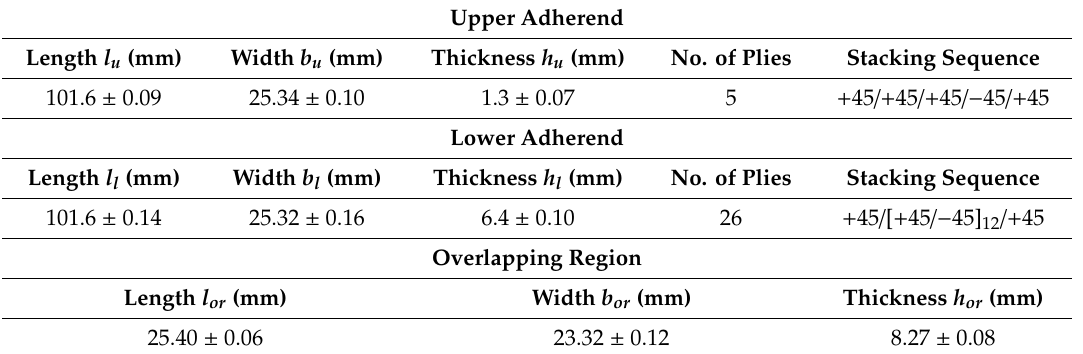
Table 3. Single Lap Shear with Rivets (SLS-R) Specimen Nomenclature, Geometry and